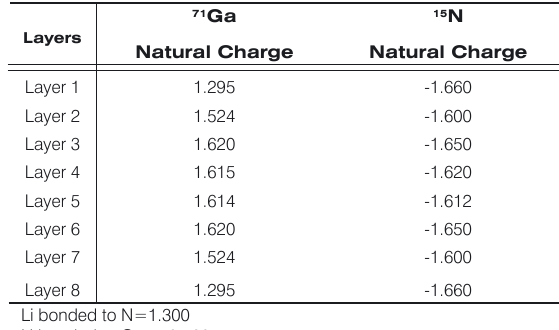
Table 6. The 71 Ga and 15 N natural charges in the Li-capped (4, 4)